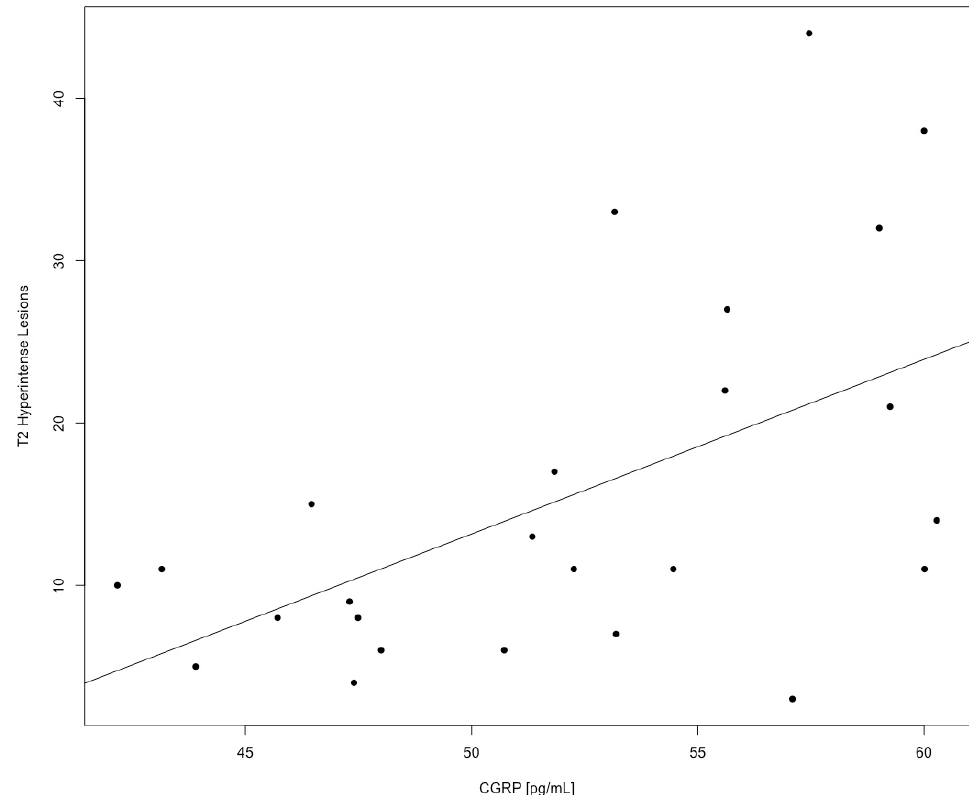
Figure 2. Linear regression plot of the α -CGRP CSF Concentration vs. Total T2 Hyperintense lesion count on MRI ( p = 0.005, Multiple R squared 0.29—Adjusted R-Squared